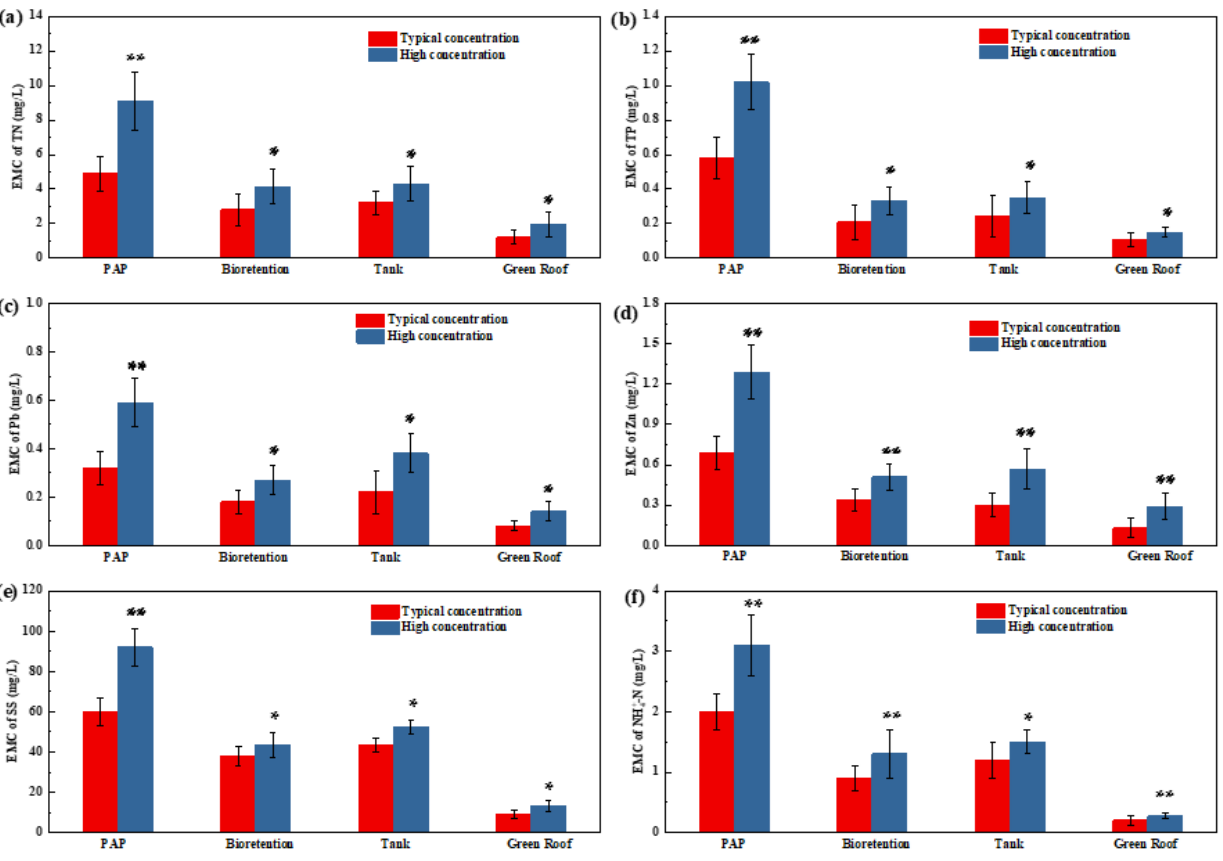
Figure 6. Event mean concentrations (EMCs) of pollutants in the PBT-GR system under two types of concentration for synthetic stormwater runoff used in the study (n = 6). * representing p < 0.1 and ** representing p < 0.05. ( a – f ) represent TN, TP, Pb, Zn, SS, NH +4 -N respectively.